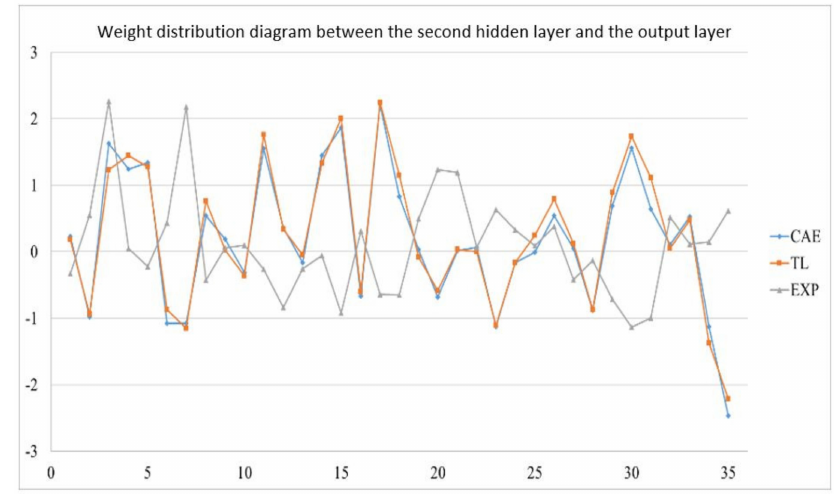
Figure 24. Weight distribution diagram between the second hidden layer and the output layer.